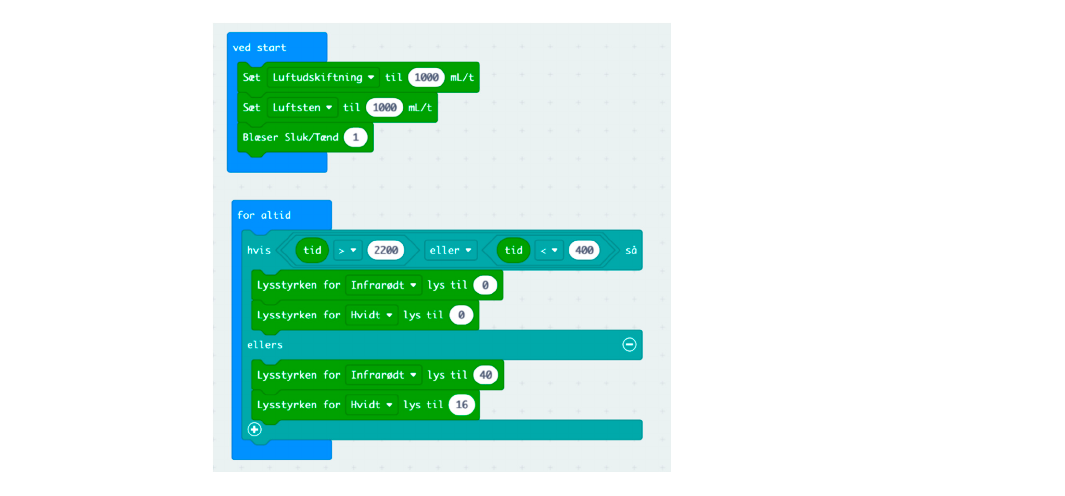
Figure 8. Example of a control program for the GrowBot made in Makecode (in Danish). This code will be compiled and transferred to the micro:bit, which is then placed in the connector on front of the GrowBot.